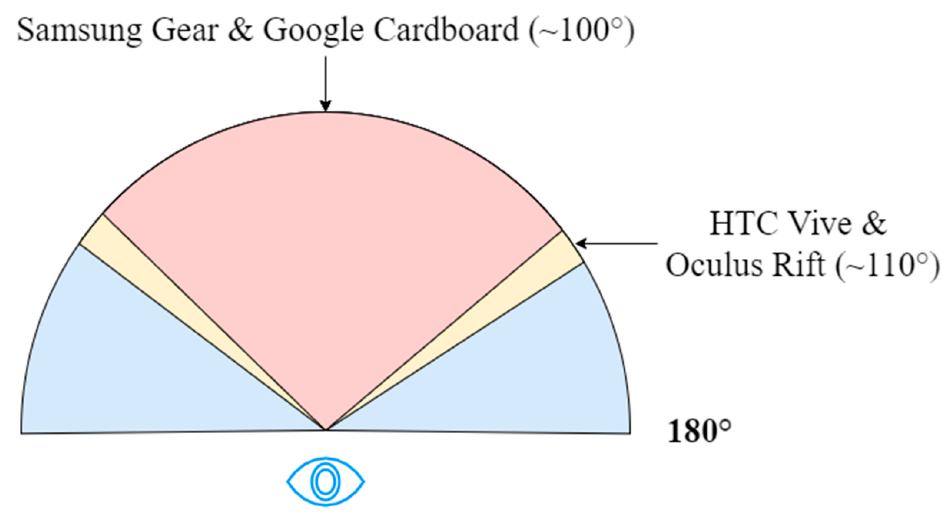
Figure 6. FoV associated with the human eye.